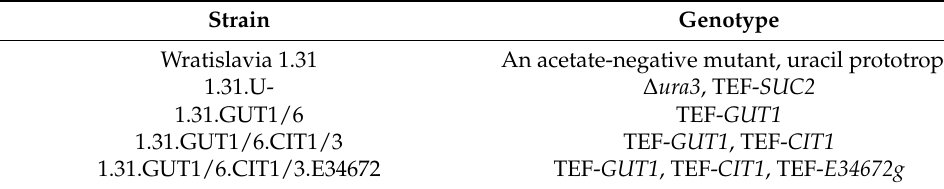
Table 7. The genotype characteristics of Y. lipolytica strains used in this